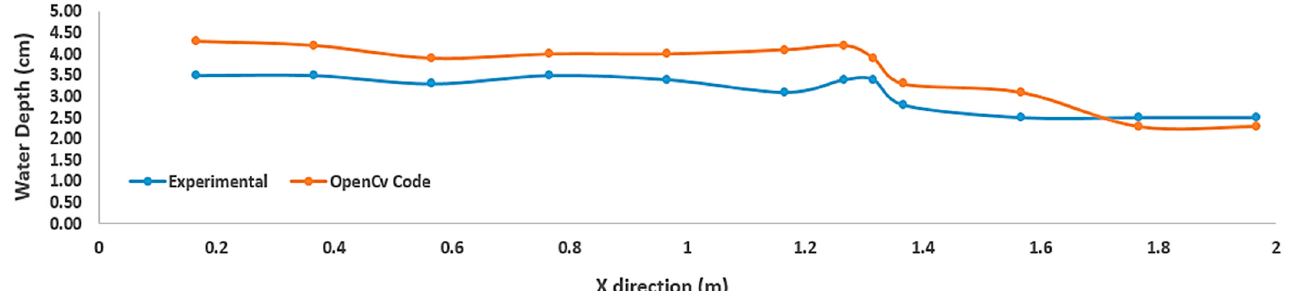
Figure 31. Experimental and OpenCV coded water depth along the X direction.